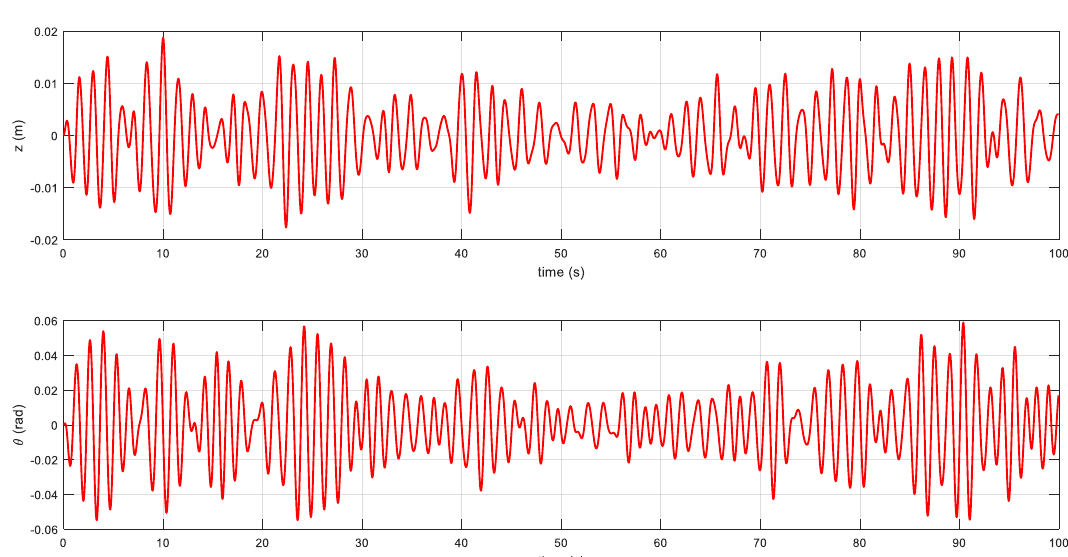
Figure 2. The JONSWAP wave spectrum and related irregular waves.